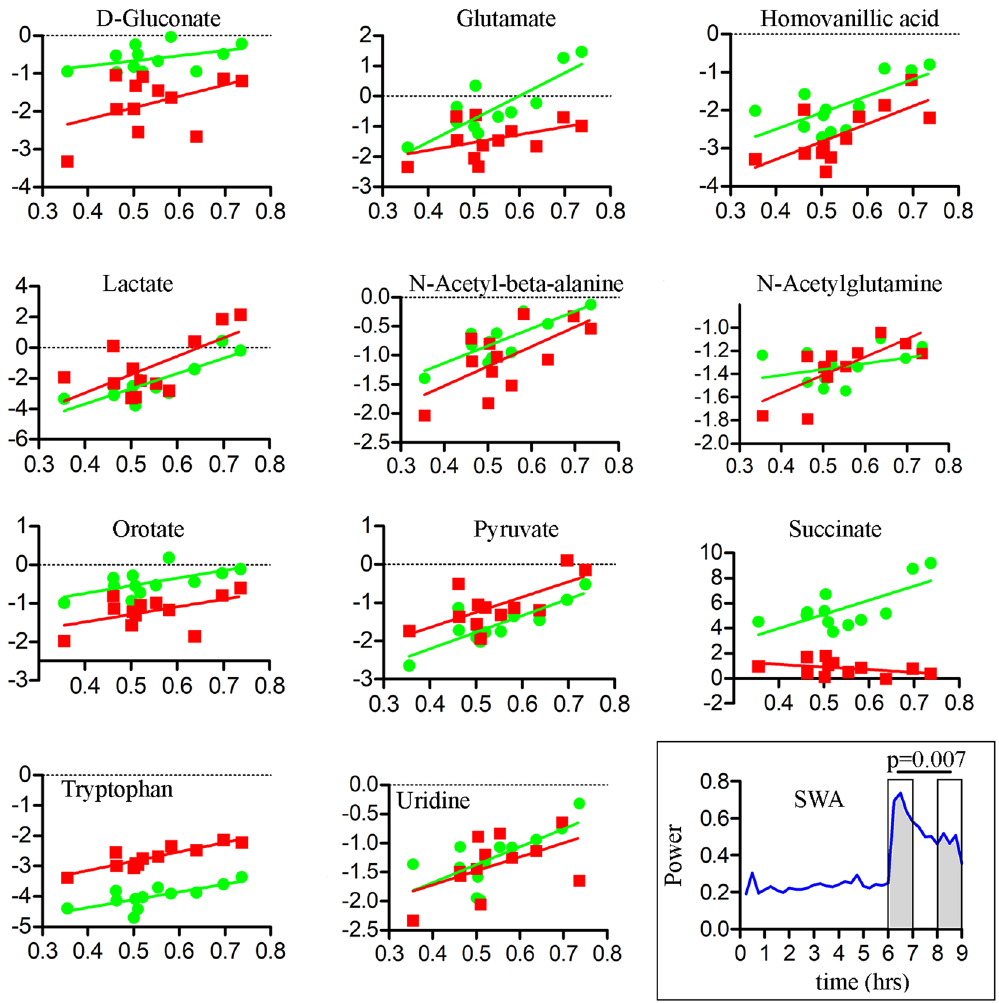
Figure 6. Correlations between levels of each compound (log transformed; y axis) and SWA during recovery sleep (x axis). Data and regression lines are depicted in green for mPFC and red for M1. The inset (bottom right) shows the averaged SWA time course (n = 6 mice) during the EW6-S3 experiment. Note the progressive SWA decline in the course of the 3 hours of recovery sleep (hours 6–9). Abbreviations: mPFC, medial prefrontal cortex; M1, primary motor cortex; SWA, slow wave activity; EW, enforced wakefulness; S,